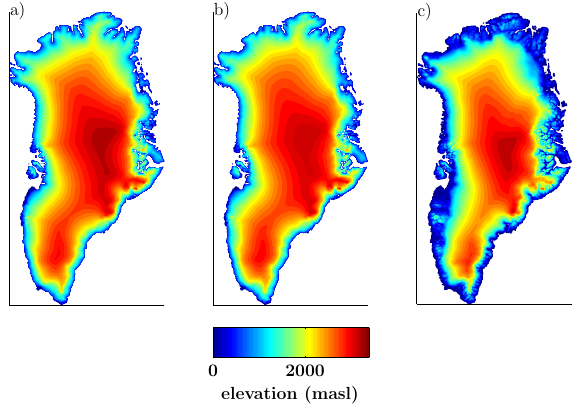
Figure 9. Surface heights for transient spin-up simulation preindus- trial state (a) , equilibrium spin-up simulation preindustrial state (b) and observed geometry (c) . Both model simulations clearly overes- timate ice thickness and resulting surface height around the margins. Figure 10. Difference in surface topography between transient and